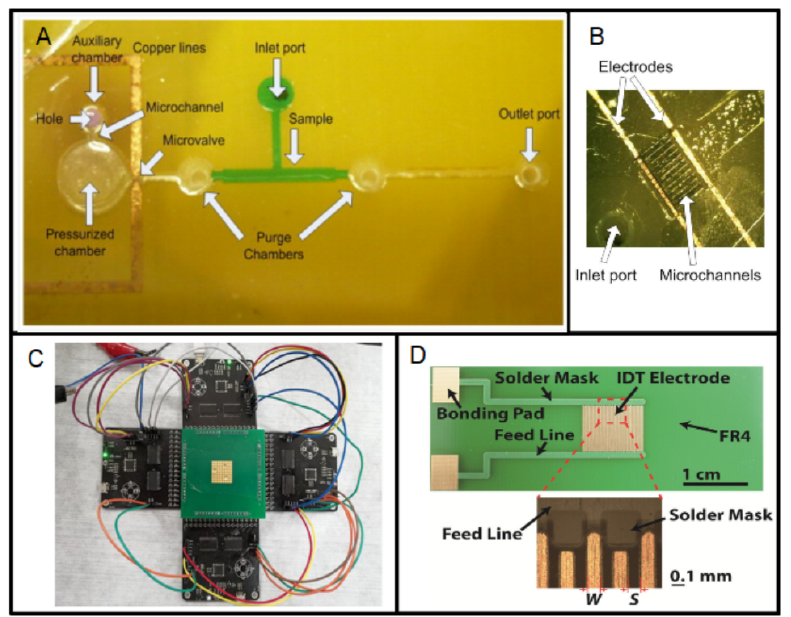
Figure 12. ( A ) Impulsion system based on an SU-8 pressurized chamber and a copper line fuse. (reprinted from [136], copyright (2015), with permission from Elsevier). ( B ) Close view of the electroosmotic part of a PCB-device where the microchannels can be seen (copyright (2013) IEEE. Reprinted, with permission, from [144]). ( C ) Device for fluid manipulation using electrowetting on dielectric on Printed Circuit Board (reprinted from [145], copyright (2020), Creative Commons License). ( D ) Electrochemical PCB-based impulsion chip with detail of the microelectrode fingers (reprinted from [150], copyright (2018), with permission from